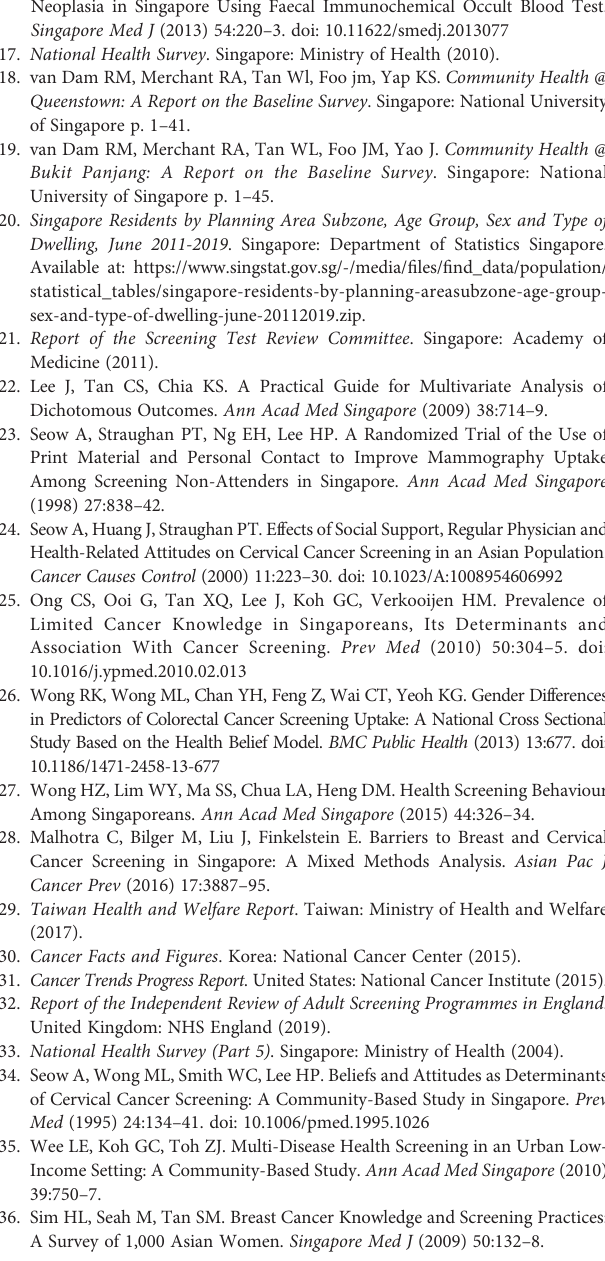
Supplementary Figure 1 | Age distributionin the survey sample in comparison to Singapore ’ s population. **Based on Singapore SingStat 2016 Population Data ages 40 and above. Supplementary Figure 2 | Gender distribution in the survey sample in comparison to Singapore ’ s population. **Based on Singapore SingStat 2016 Population Data ages 40 and above. Supplementary Figure 3 | Ethnic distribution in the survey sample in comparison to Singapore ’ s population. **Based on Singapore SingStat 2016 Population Data ages 40 and